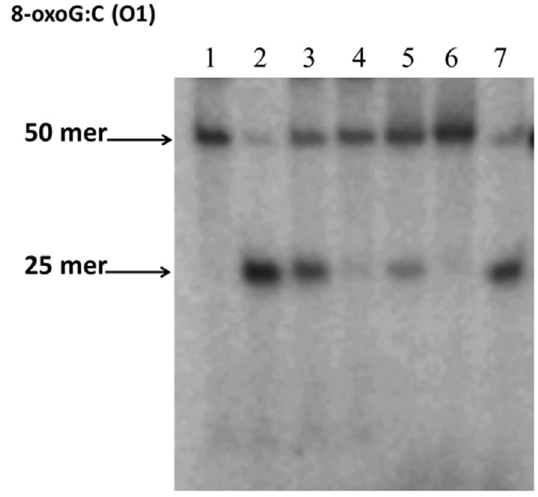
5 9 -end-labeled oligonucleotides (O1) was incubated with rPG1037 for 20 min, H 2 0 2 for 10 min then Fpg enzyme for 30 min, electrophoresed and visualized. Lane 1 contains O1; Lane 2 contains O1 and Fpg enzyme; Lane 3 contains O1, 1 m g rPG1037 and Fpg enzyme; Lane 4 contains O1, 2 m g rPG1037 and Fpg enzyme; Lane 5 contains O1, 1 m g rPG1037, 2 mM H 2 0 2 and Fpg enzyme; Lane 6 contains O1, 2 m g rPG1037, 2 mM H 2 0 2 and Fpg enzyme; Lane 7 contains O1, Fpg enzyme